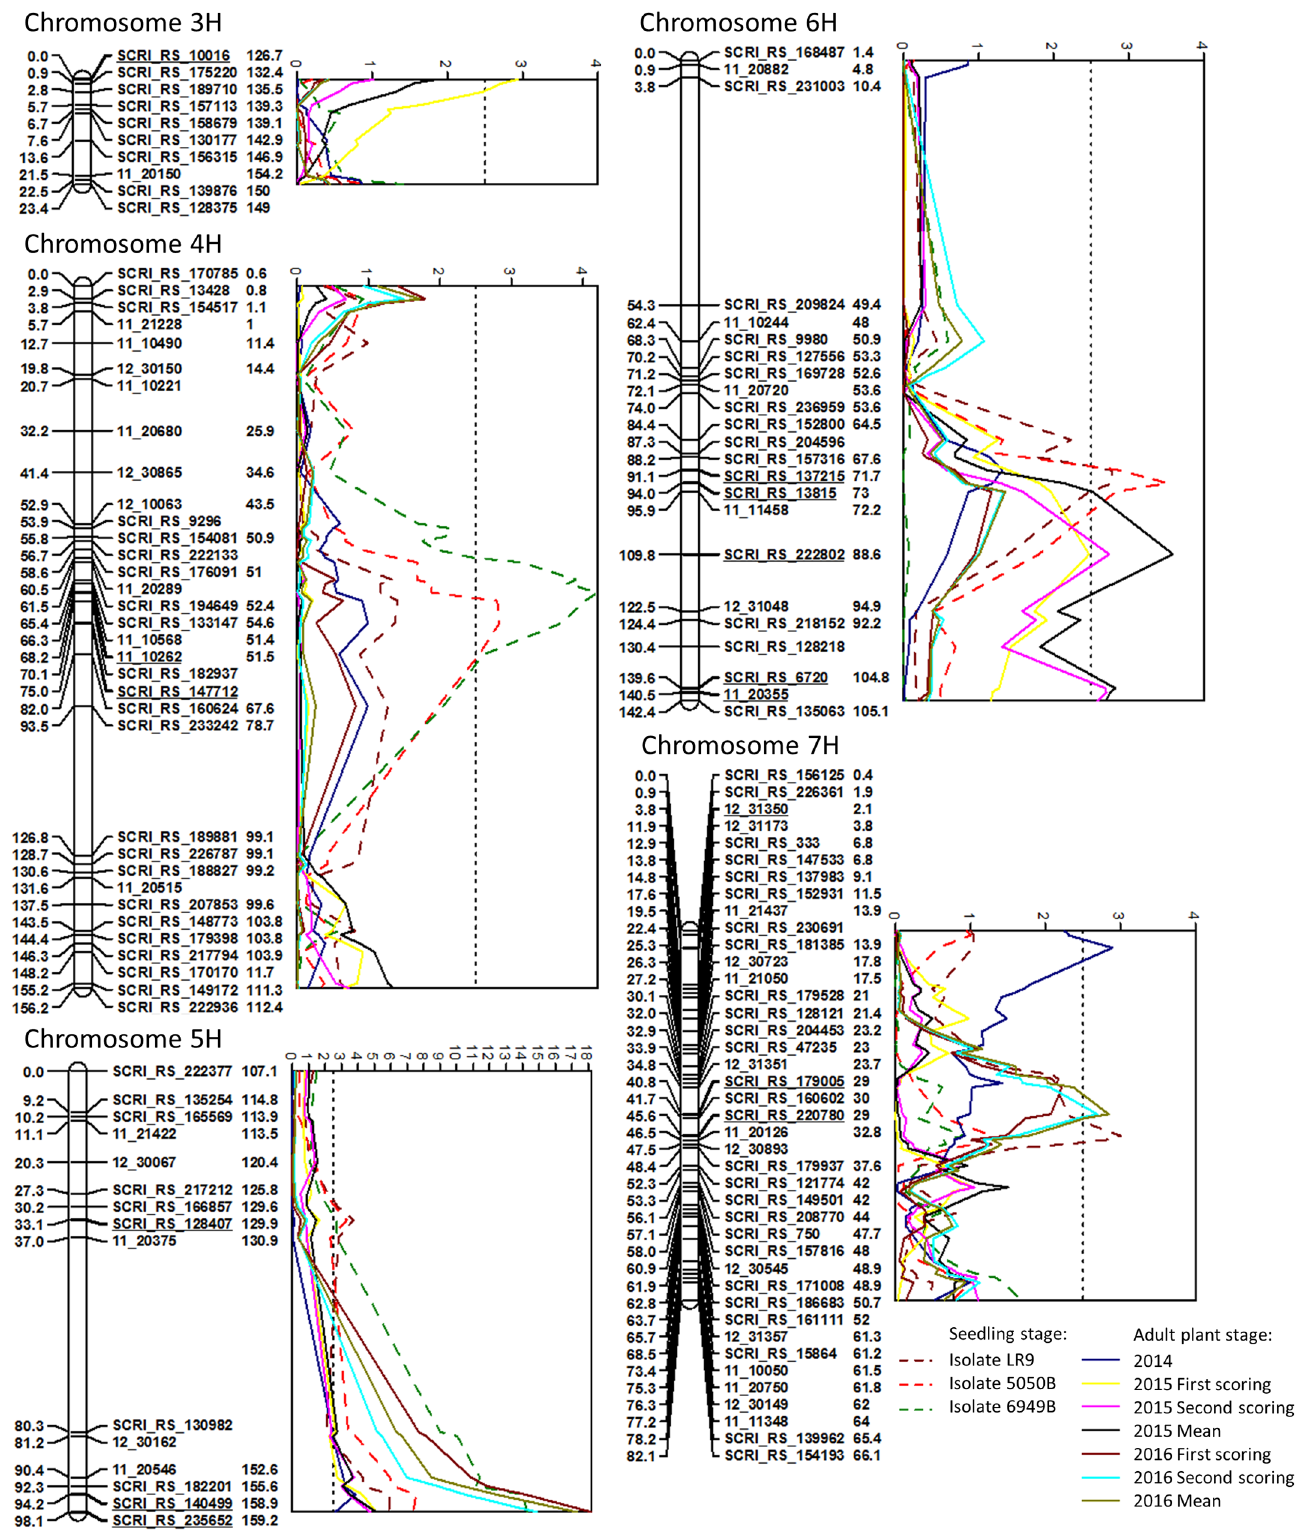
Fig 2. Chromosomes with significant QTL for net blotch resistance with LOD curves obtained with interval mapping. Genetic distanceson the AxL map are given in cM on the left side of the linkagemap bars. The numberson the right side of the marker names refer to the POPseq position